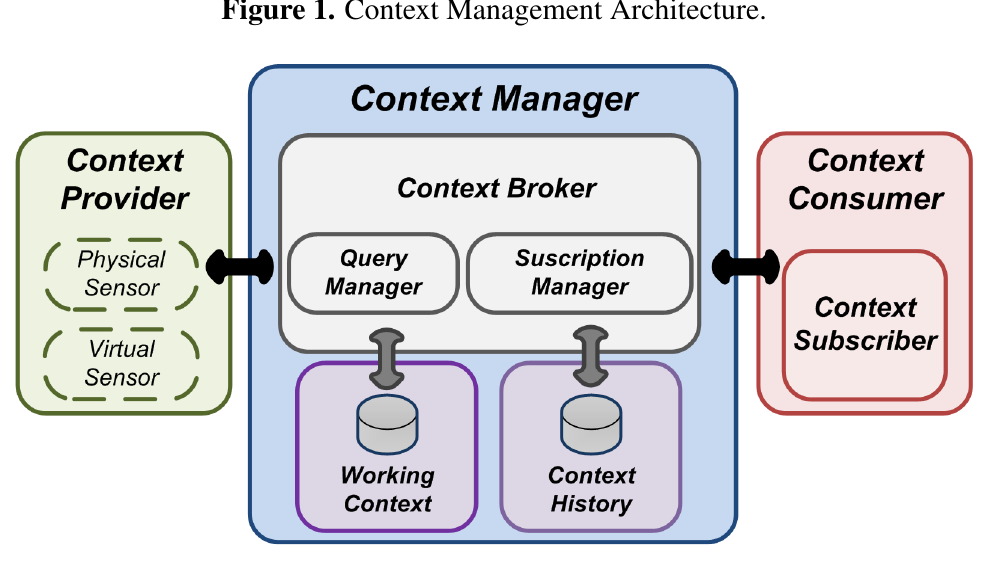
Figure 1. Context Management